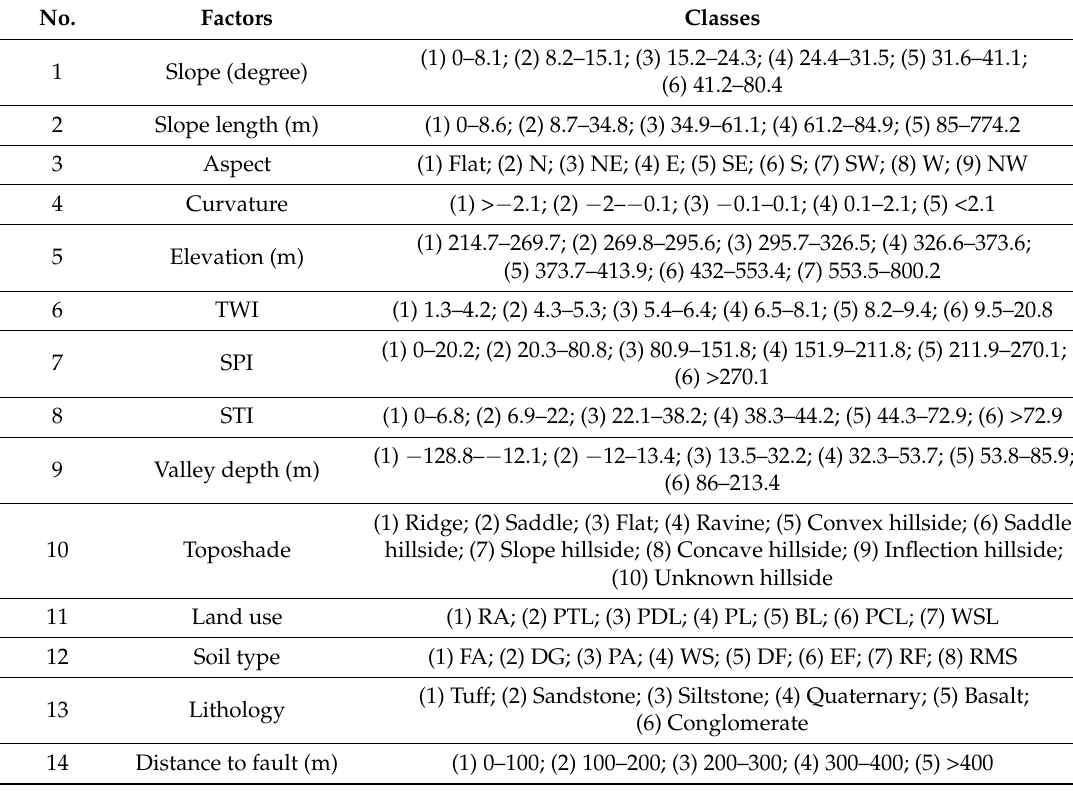
Table 1. Landslide conditioning factors and their